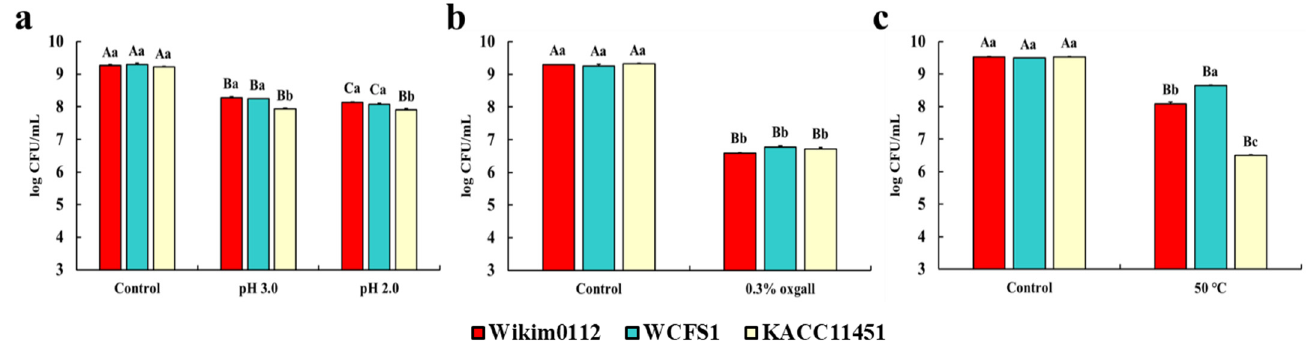
Figure 2. Gastrointestinal environment and heat tolerance of Lpb. plantarum Wikim0112, WCFS1, and KACC11451. All Lpb. plantarum strains were exposed ( a ) without (control) or with 0.3% ( w / v ) pepsin at pH 6.5 (control), 3.0, or 2.0 for 4 h, ( b ) without (control) or with 0.1% ( w / v ) pancreatin and 0.3% ( w / v ) bile salt (oxgall) for 24 h, and ( c ) 30 (control) or 50 °C for 1 h. The values represent the mean ± SEM (n = 3). Different uppercase letters represent significant difference between the same strains ( p < 0.5), while different lowercase letters represent significant difference between the same treatment groups ( p < 0.5).